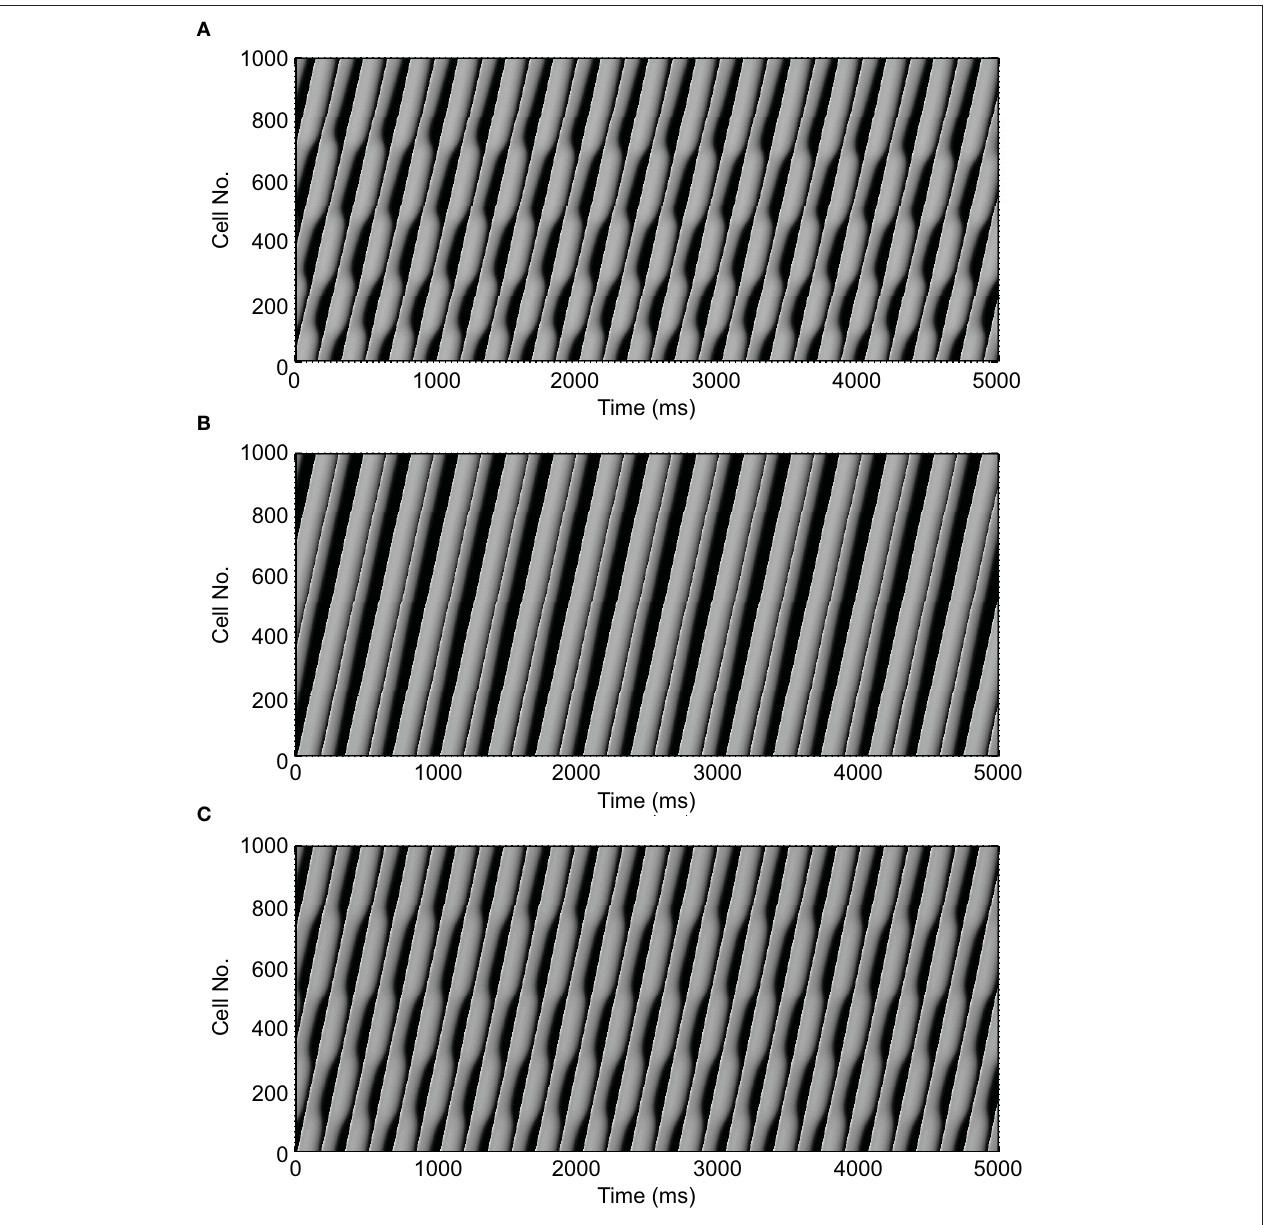
FIGURE 3 | Time-space plots of the last 30 beats at CL of 169ms during normal conduction and the two situations of SNC. The figure shows that discordant alternans formed during normal conduction (A) and that it was eliminated when gate j was set equal to 1 (B) , but not when I Na was increased for all beats (C) . Note that both circumstances, in (B,C) , had negative CV restitution. (A) is reproduced from our previous study (Jing et al.,